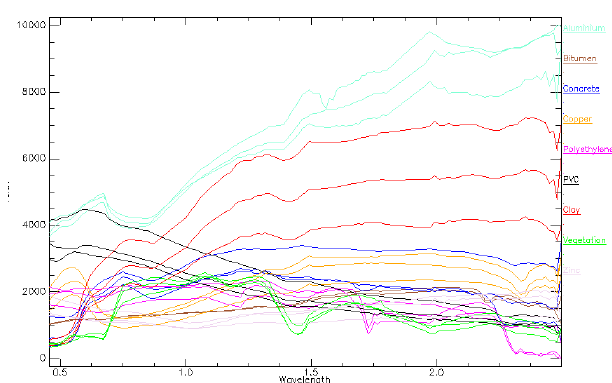
Figure 5: The 27 spectra analyzed, belonging to roofs composed of 9 materials.